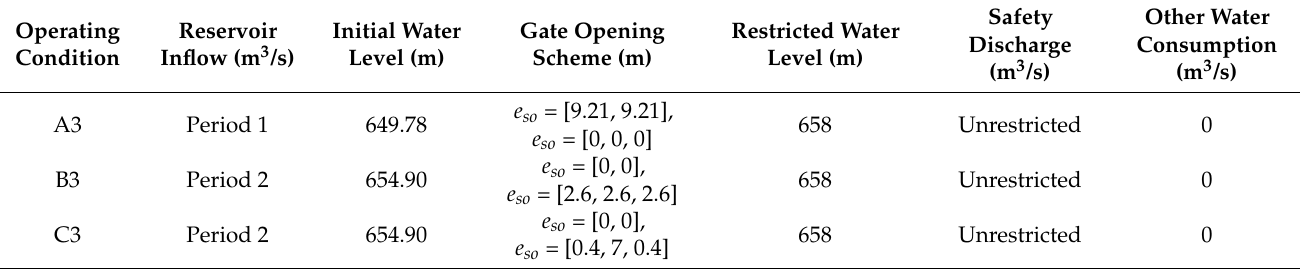
Table 10. Simulated conditions of plug-in model of reservoir flood regulating calculation.